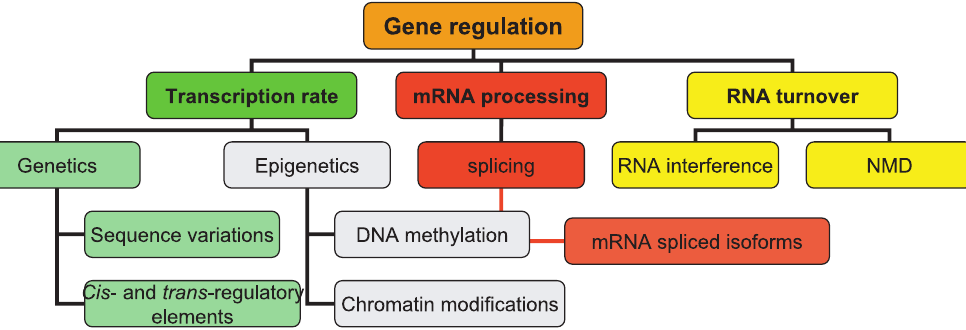
Figure 2. Gene expression regulatory mechanisms: schematic overview. Gene expression represents a multistep pathway that involves highly regulated and interconnected events; conceptually, it could be divided on transcription, mRNA processing and RNA turnover. Transcription rate is settled on genetic and epigenetic features of gene sequence; differential mRNA processing includes alternative splicing of transcripts, and RNA turnover rate which is determined by RNA stability depends on the RNA interference and nonsense mediated decay (NMD). doi:10.1371/journal.pone.0011067.g002 PLoS ONE |